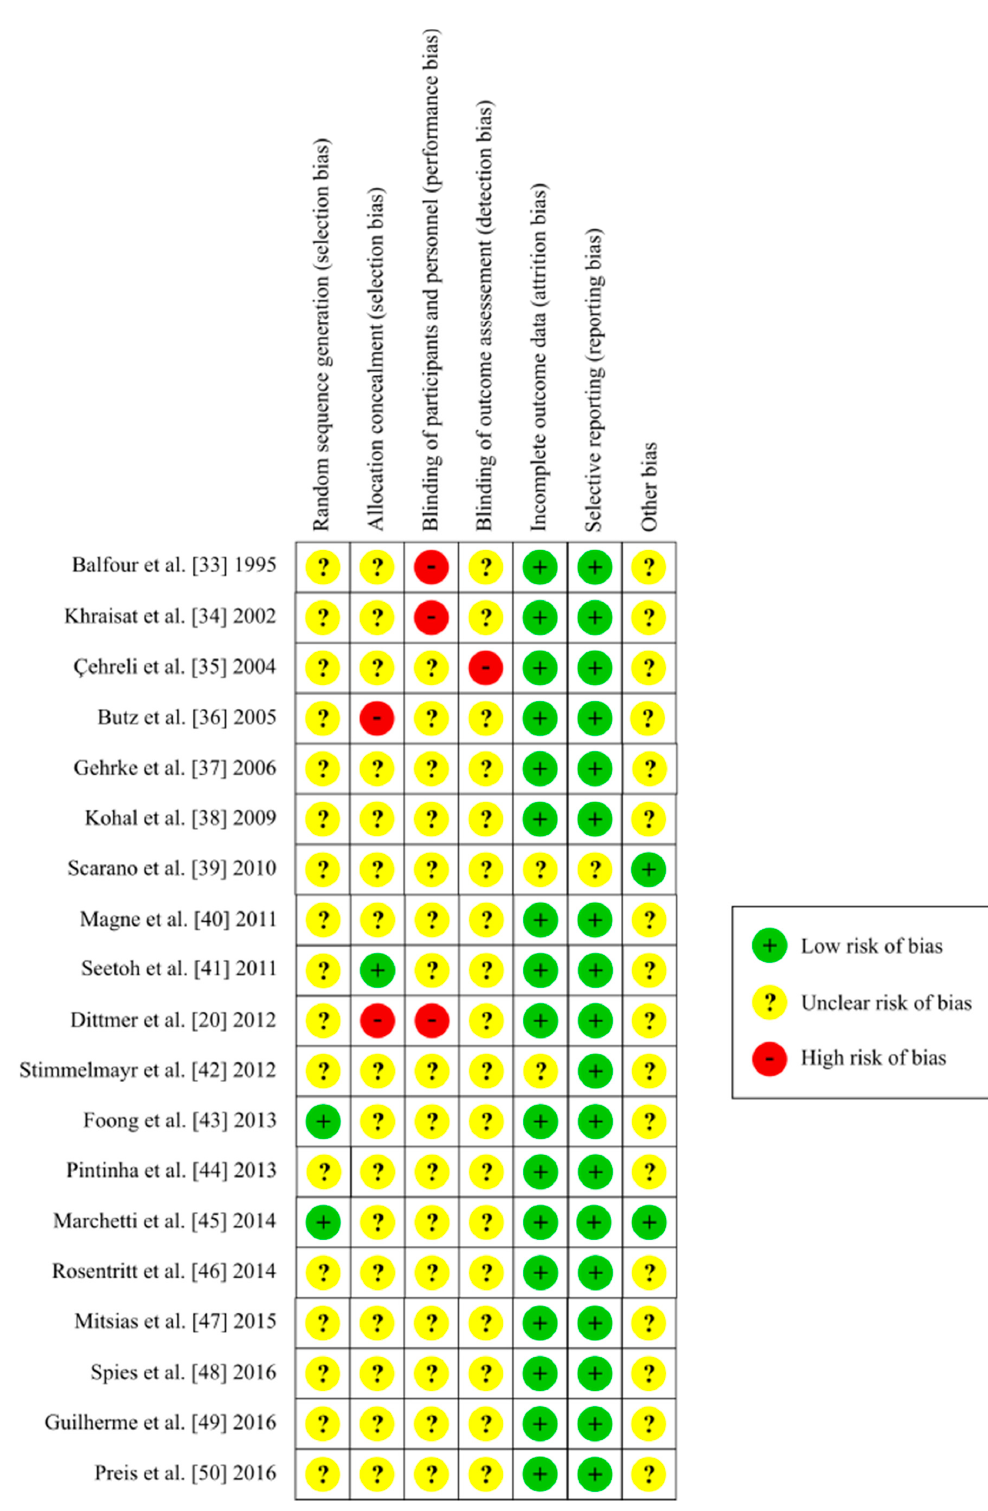
Figure 3. Assessment of risk of bias of included studies.